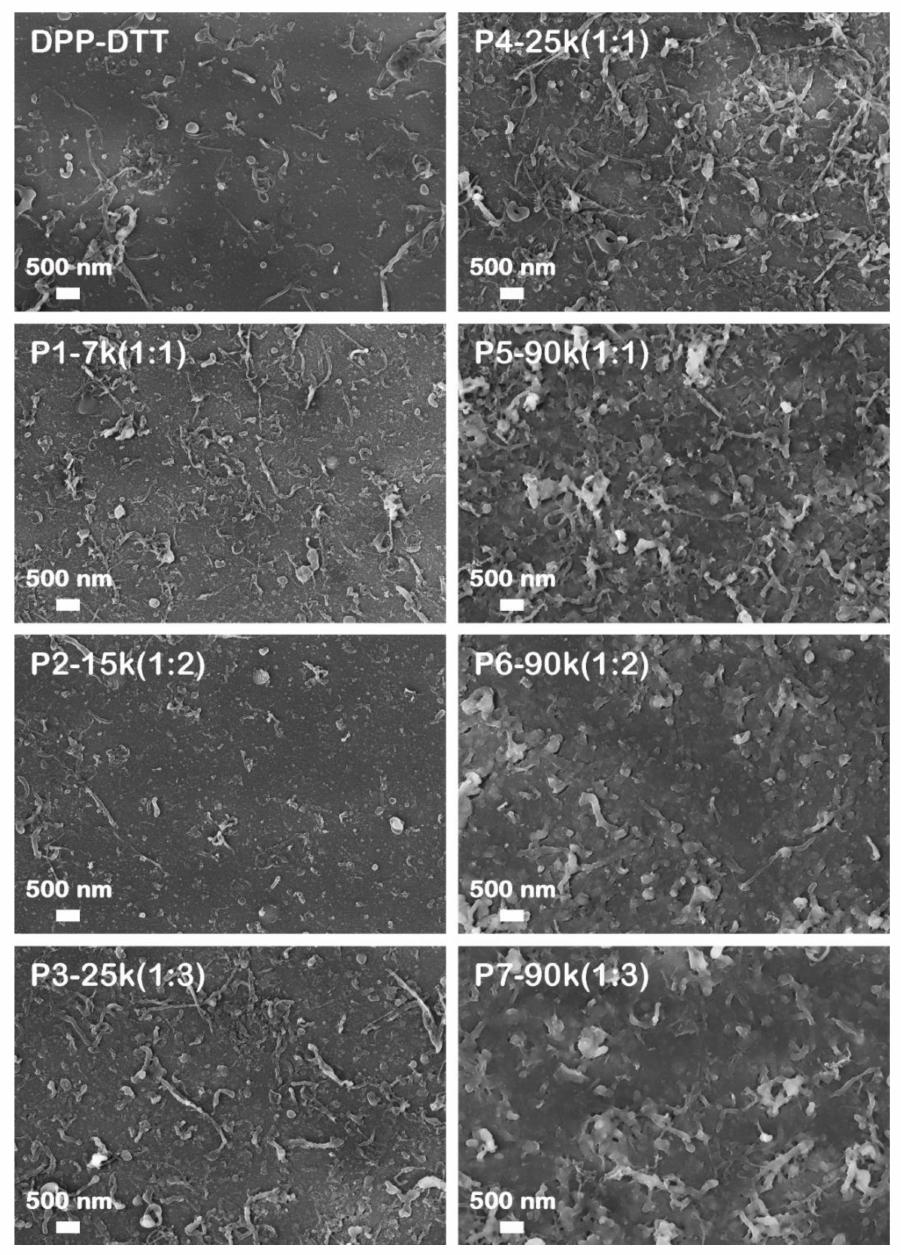
Figure 5. FESEM images of the layers deposited by